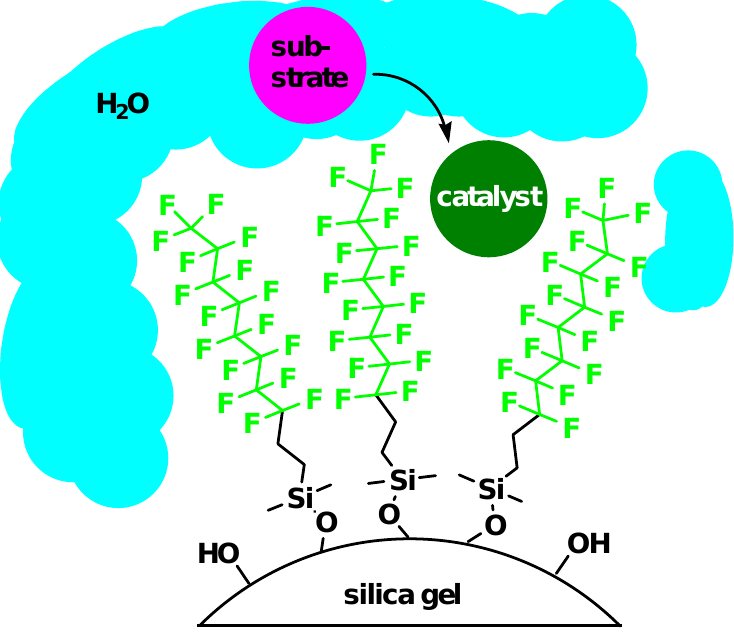
Figure 4. Fluorous silica gel-supported Lewis acid catalyst